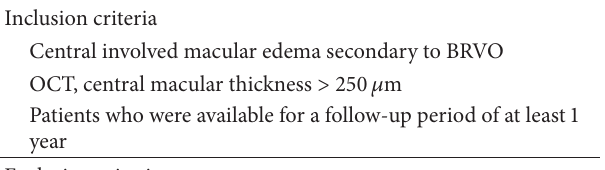
Table 1: Inclusion and exclusion criteria of patients in this study. Inclusion criteria Central involved macular edema secondary to